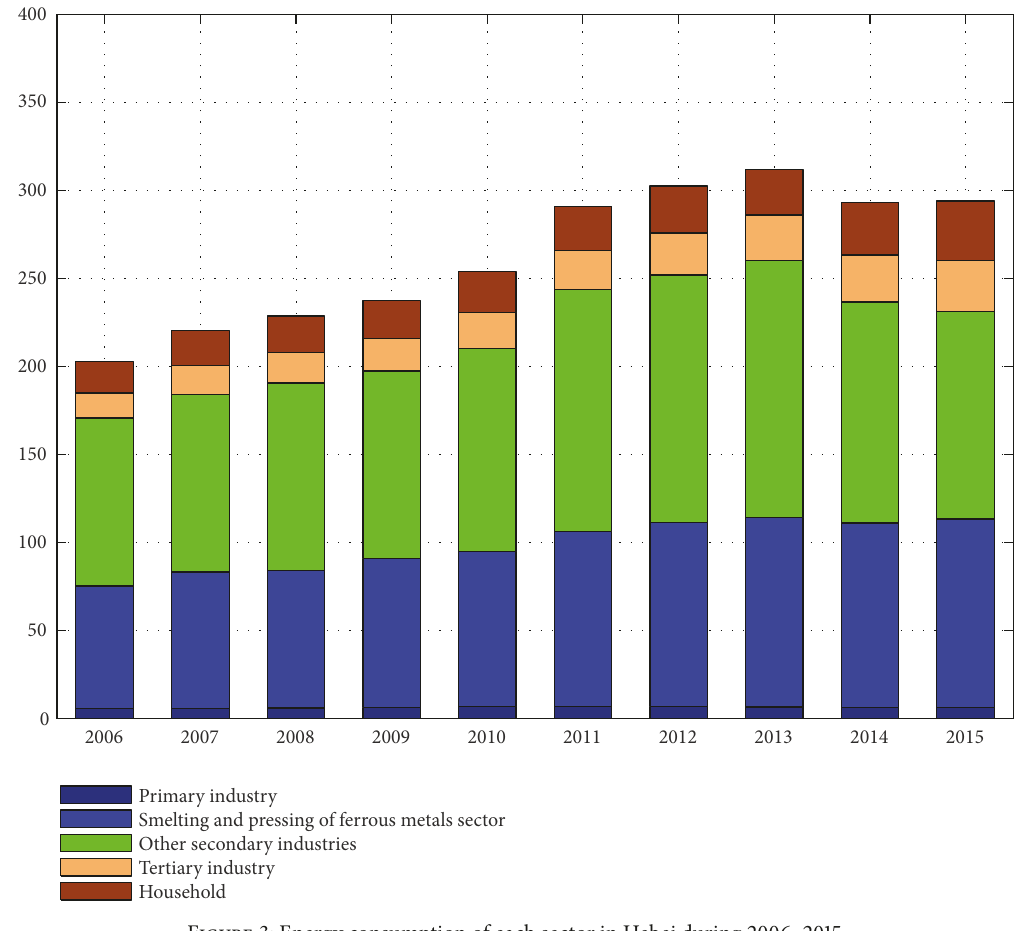
Figure 3: Energy consumption of each sector in Hebei during